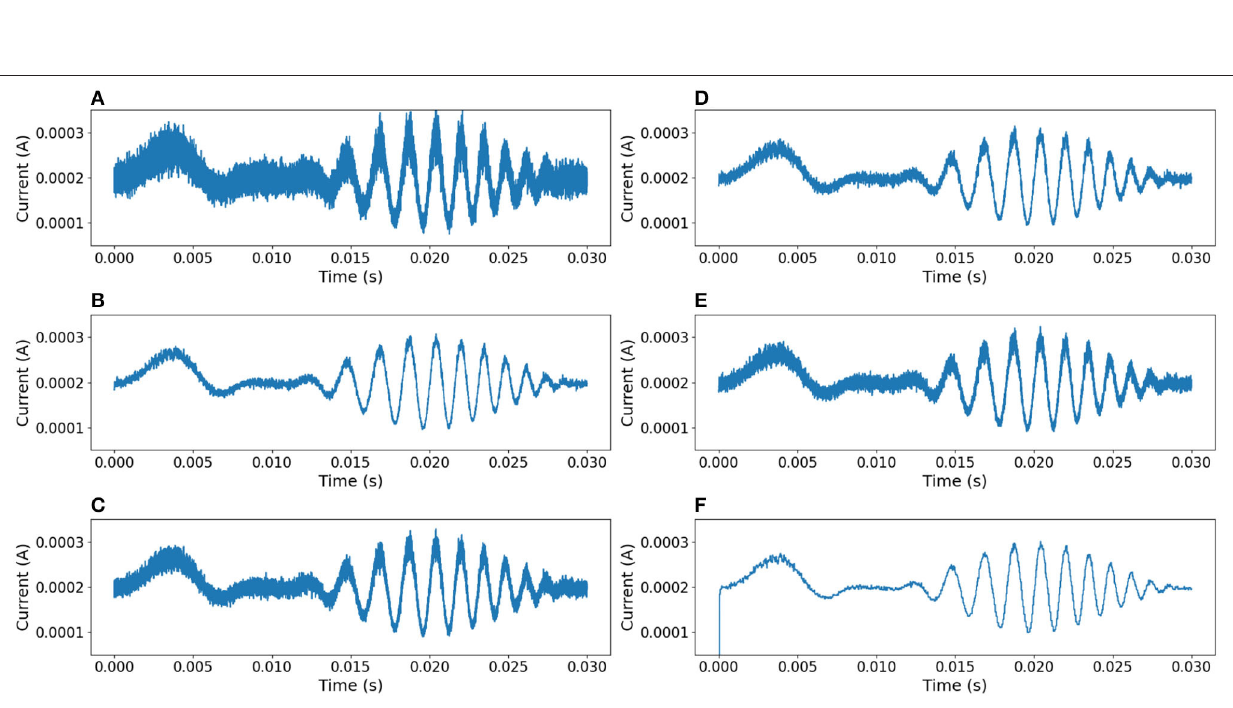
Frontiers in Neurorobotics | www.frontiersin.org 8 June 2022 | Volume 16 | Article